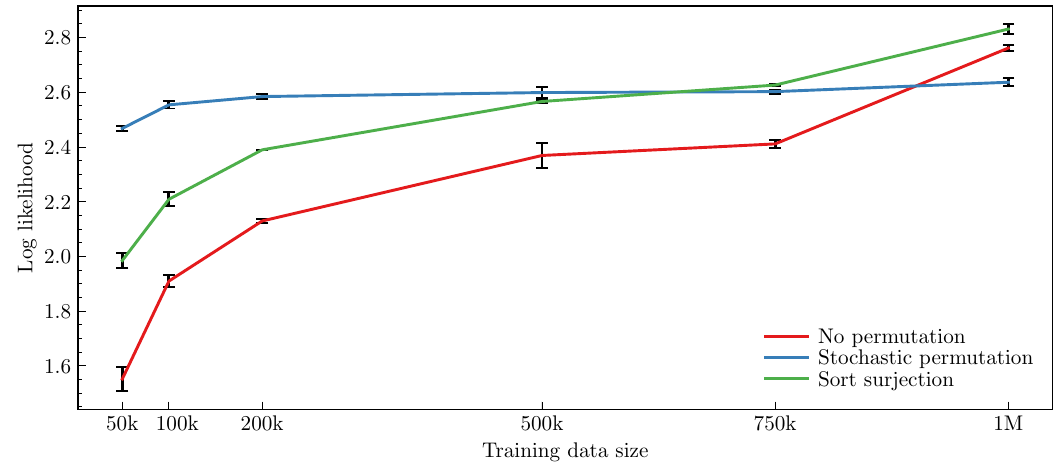
Figure 6: The development of the test log likelihood (higher is better) of models without permutation transform (red), with stochastic permutation (blue) or with sort surjection (green). The points and error bars correspond with the mean and standard deviation over three independent training